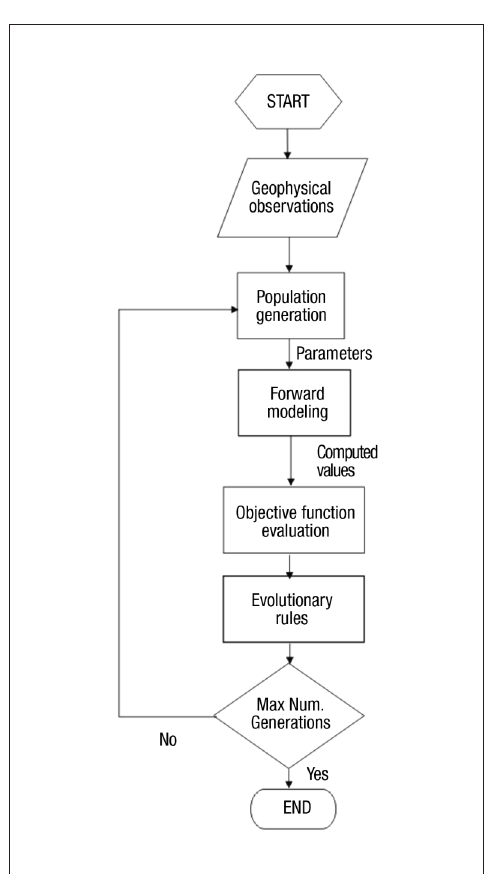
Fig. 1. Schematic of GA